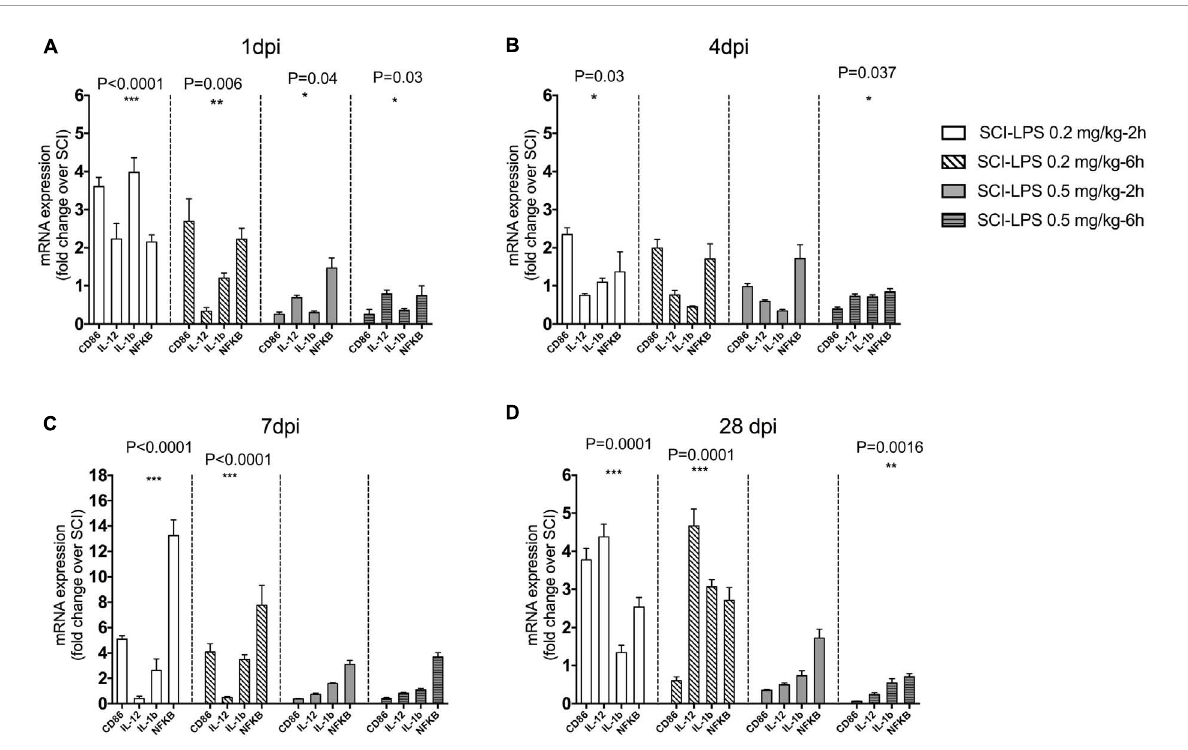
FIGURE3 The effect of immediate (2 h) and early (6 h) administration of two sub-toxic doses of LPS on a pro-inflammatory marker after SCI. Adult male rats received the moderate contusion SCI and LPS treatment initiated at 2 or 6 h post-SCI. Real-time PCR quantification was performed to evaluate pro-inflammatory markers at 1 (A) , 4 (B) 7 (C) , and 28 (D) days after SCI. Gene expression is normalized to the same-day SCI group. Regardless of injection time, LPS 0.5 mg/kg significantly reduces mRNA level pro-inflammatory at 1, 4, and 28 dpi compared to the SCI. There was a trend to increase pro-inflammatory gene during 28 days after the SCI in low-dose LPS (0.2 mg/kg) treatment groups. Days * P < 0.05, ** P < 0.01, *** P < 0.001 versus SCI (main effect of treatment), n = 3, mean + SEM n = 3 for each group.